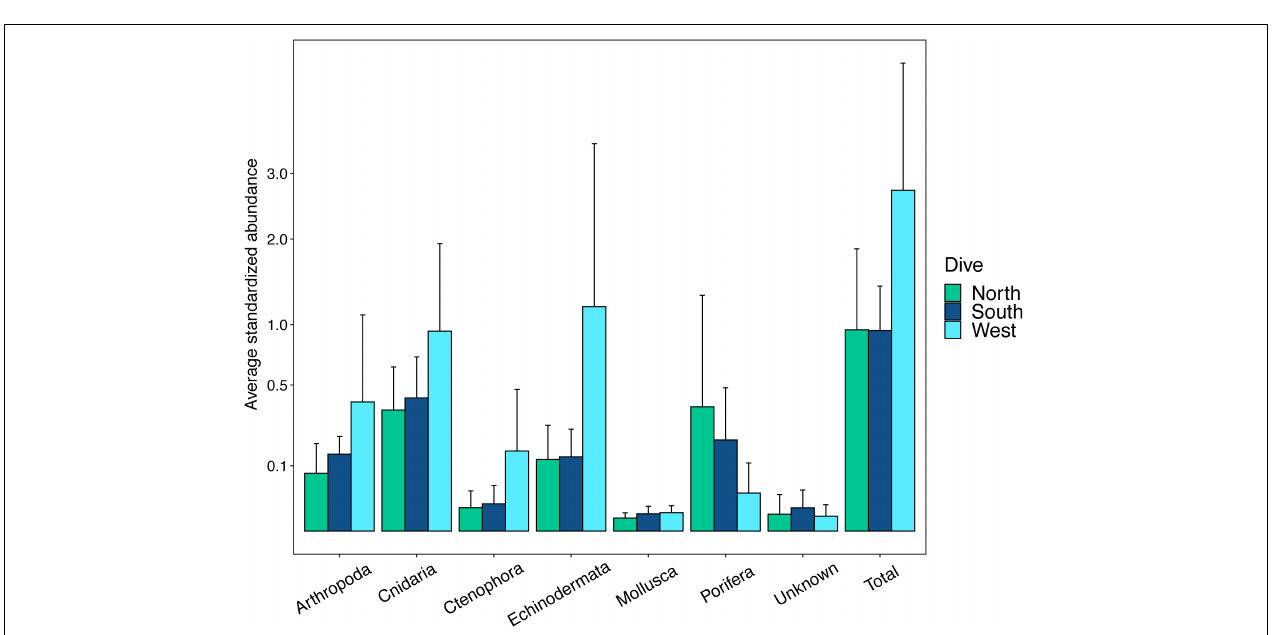
FIGURE 7 | Abundances of major phyla on the three slopes. Abundances are standardized as the number of individuals per number of photos taken in each transect. The y -axis values are square root scaled for easier visualization of values.